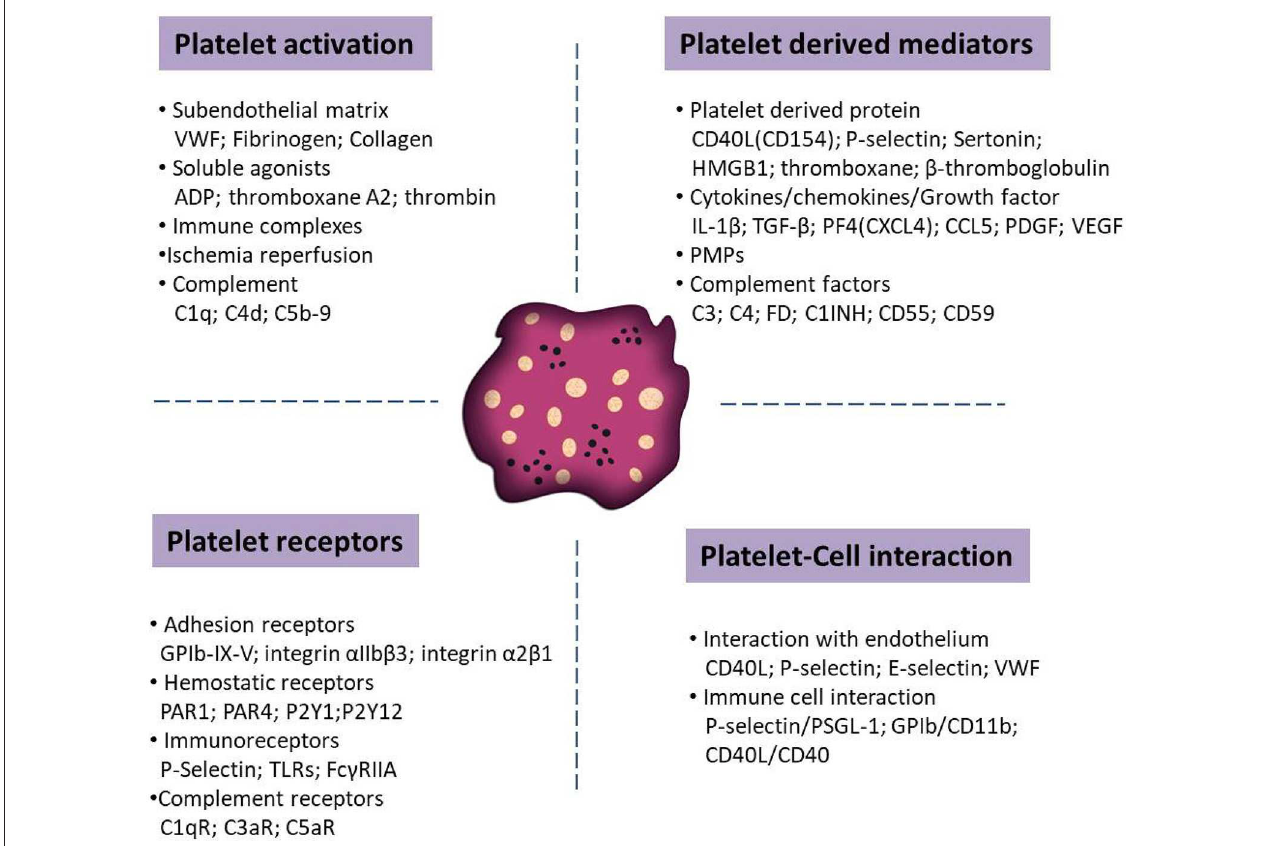
FIGURE 1 | Schematic overview of distinct molecules that tune the function of platelets in autoimmune diseases. Relevant molecules has been categorized into platelet activators, soluble factors released from platelets upon activation, surface receptors that mediate the interaction with other cells and receptors that trigger platelet adhesion and